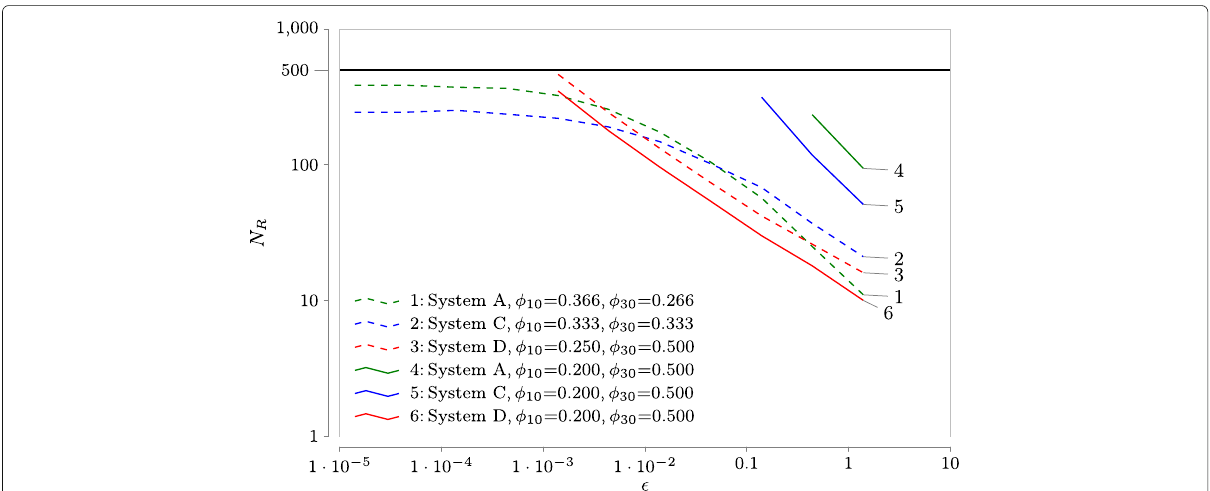
Fig. 3 Log-log plot of the number of consecutive iterations yielding realistic behavior ( N R ) versus the parameter value of (cid:14) for several systems and initial values. Since the duration of the simulation was limited to 500 iterations, only the unambiguous values smaller than 500 iterations are chosen